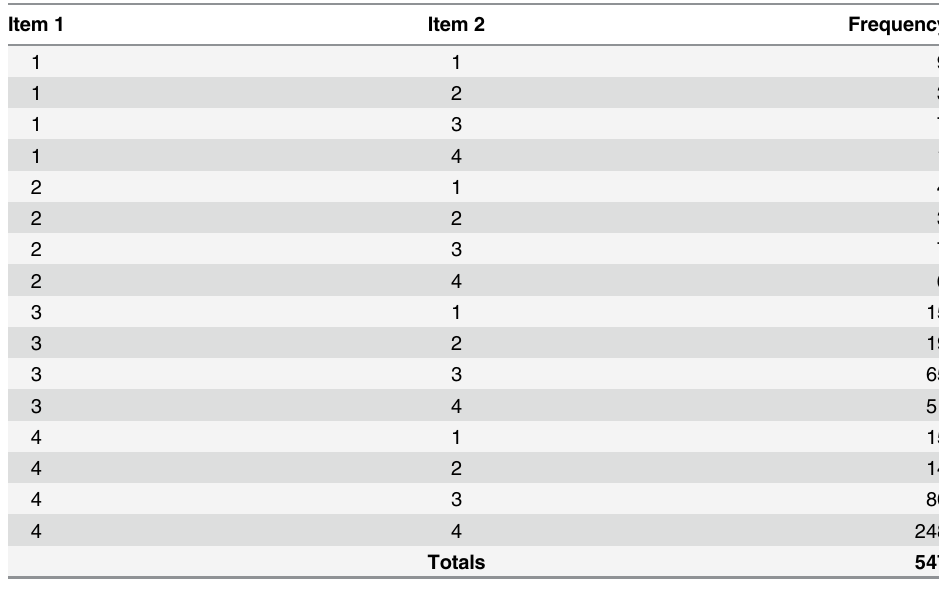
Table 5. National Alcohol Survey